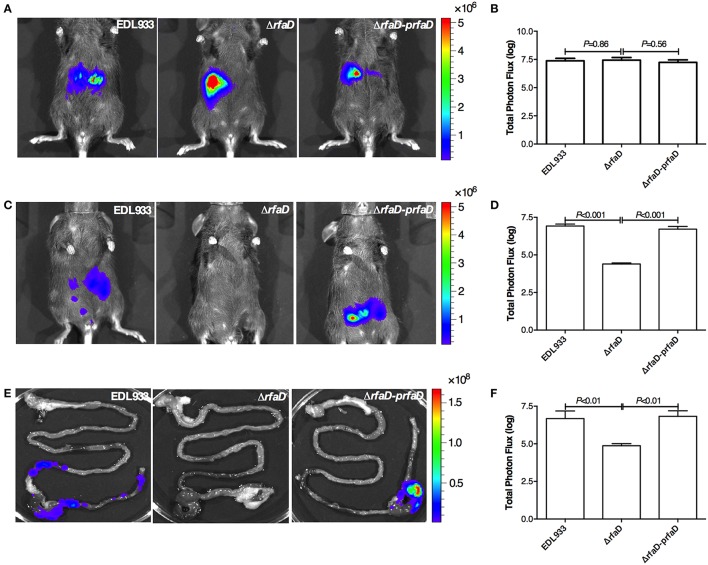
Disruption of rfaD reduces EDL933 colonization in the intestines of mice. (A) Represent images of mice inoculated with bioluminescence-labeled wild-type EHEC EDL933 (EDL933), EDL933:ΔrfaD (ΔrfaD), and EDL933:ΔrfaD-prfaD (ΔrfaD-prfaD) 1 h post infection. (B) Quantification of bioluminescence intensity of mice infected with EDL933, EDL933:ΔrfaD and EDL933:ΔrfaD-prfaD 1 h post infection. (C) Represent images of mice inoculated with bioluminescence-labeled wild-type EHEC EDL933 (EDL933), EDL933:ΔrfaD (ΔrfaD), and EDL933:ΔrfaD-prfaD (ΔrfaD-prfaD) 2 days post infection. (D) Quantification of bioluminescence intensity of mice infected with EDL933, EDL933:ΔrfaD and EDL933:ΔrfaD-prfaD 2 days post infection. (E) Represent images of intestinal tissues of mice infected with bioluminescence-labeled wild-type EHEC EDL933 (EDL933), EDL933:ΔrfaD (ΔrfaD), and EDL933:ΔrfaD-prfaD (ΔrfaD-prfaD). (F) Quantification of bioluminescence signals of intestinal tissues of bioluminescent EHEC infected mice 2 days post infection. The color scale represents the radiance (p/sec/cm2/sr). Representative images are shown. All experiments were conducted independently three times with 3 animals each time, and error bars indicate the standard deviations.